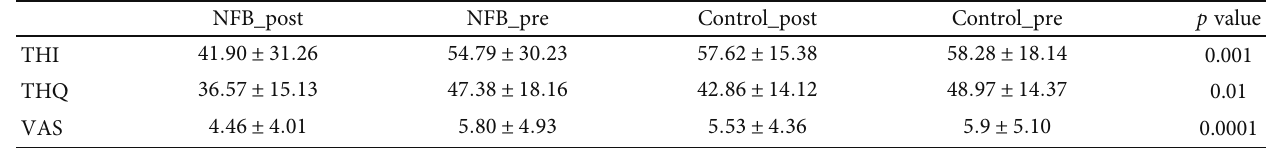
Table 2: Self-reported tinnitus scores for the two groups after NFB